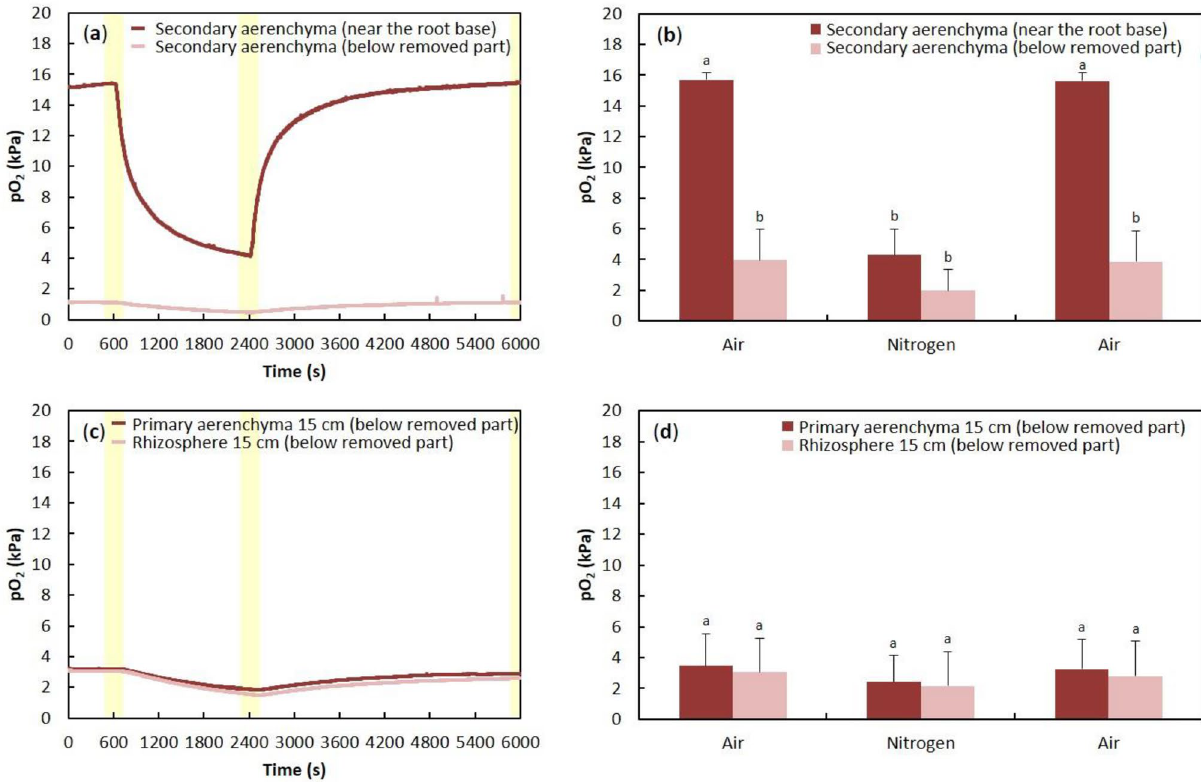
Figure 5. Changes in oxygen partial pressure above and below secondary aerenchyma that was removed 150 days after treatment in agar media ( a , b ). Changes in oxygen partial pressure in primary aerenchyma with an intact cortex and rhizosphere after secondary aerenchyma removal 150 days after treatment in agar media ( c , d ). Secondary aerenchyma was removed near the root base (Fig. 4). ( a ) Time-trace of pO 2 in secondary aerenchyma at two different positions above and below where secondary aerenchyma had been removed from the root.